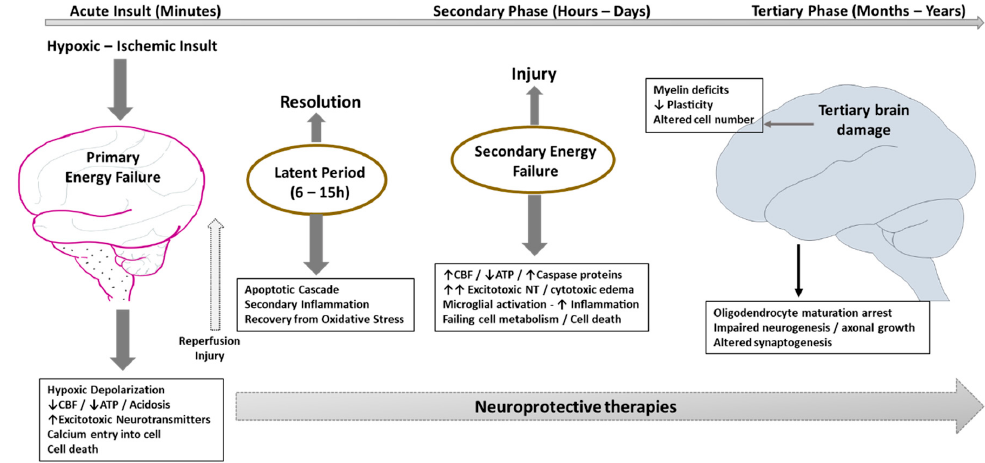
Figure 1. Schematic illustration of pathophysiology of HIE in relation to hypoxic ischemic (HI) insult resulting in primary (acute phase) and secondary energy failure (secondary phase) in the brain.